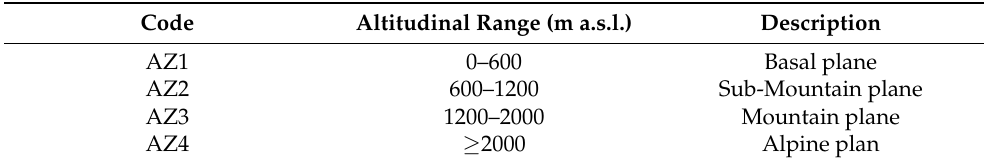
Table 4. Altitudinal range used in this